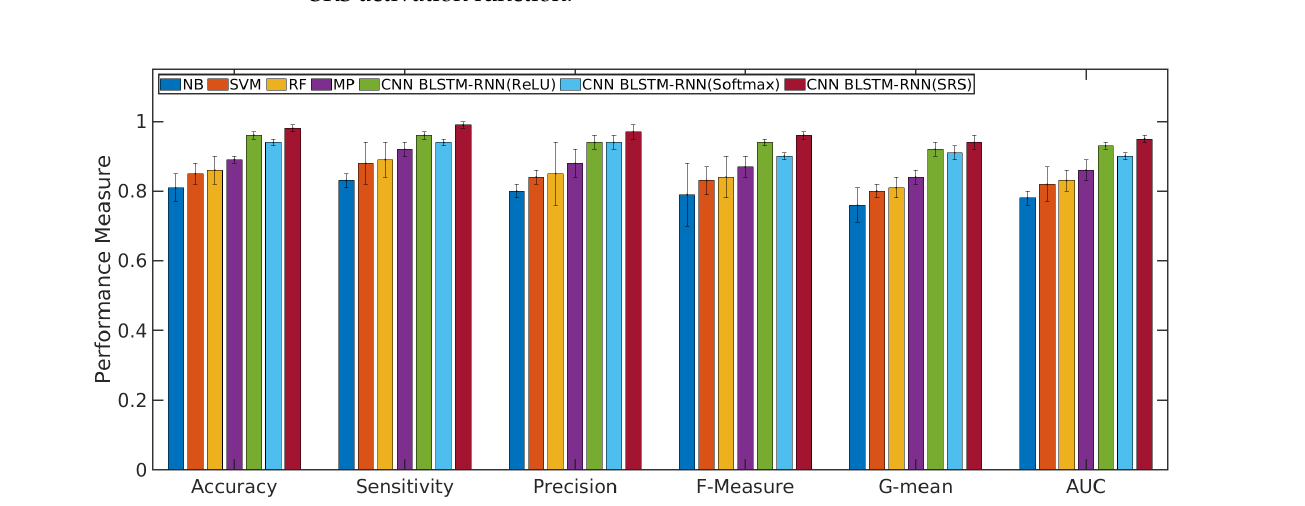
Figure 4. Results of machine learning algorithms for classifying the positive